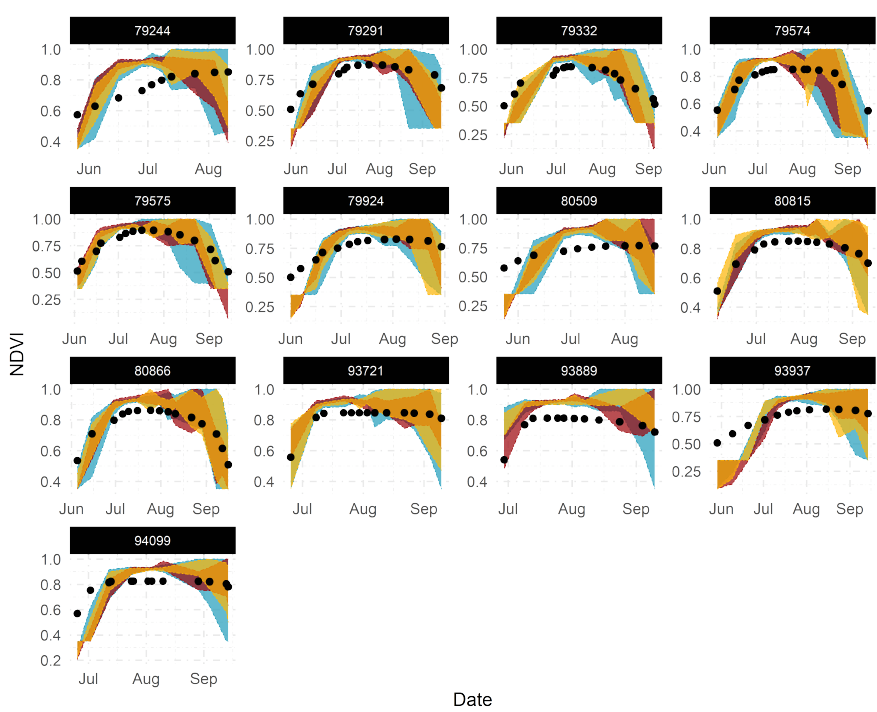
Figure A3. 95 % confidence interval for NDVI predictions made by the emulators across all the sites using the optimized parameters obtained from different optimization